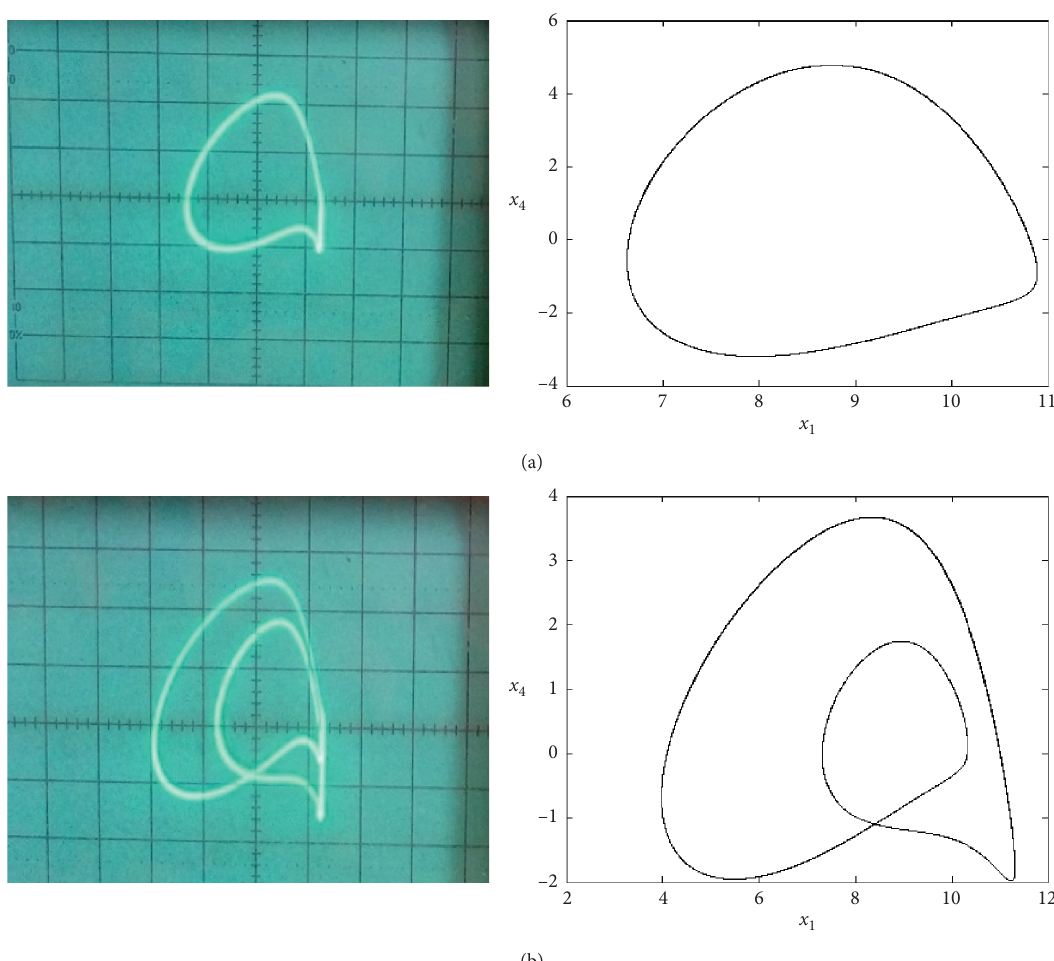
Figure 20: Bifurcation diagrams showing local maxima of the coordinate x parameter a (bubbling): (a) period-2 bubble for c � 2 . 5442, (b) period-4 bubble for c � 2 . 8442, (c) period-8 bubble for c � 2 . 9, (d) single- band chaos bubble for c � 2 . 93, (e) single-band chaos bubble for c � 2 . 99, and (f) double-band chaos bubble for c � 3 . 0.